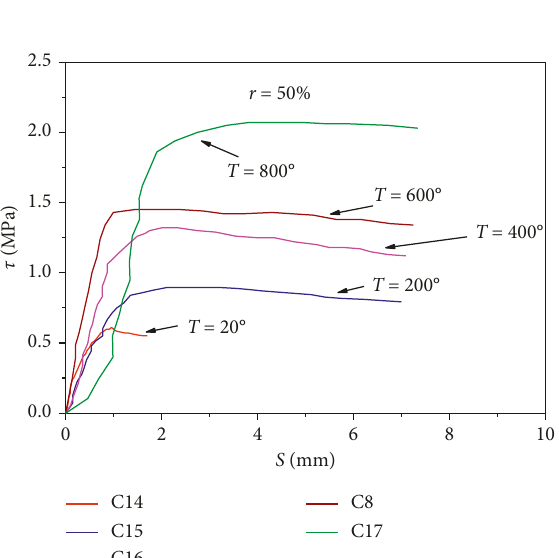
Figure 3: Typical bond stress-slip after exposure to different